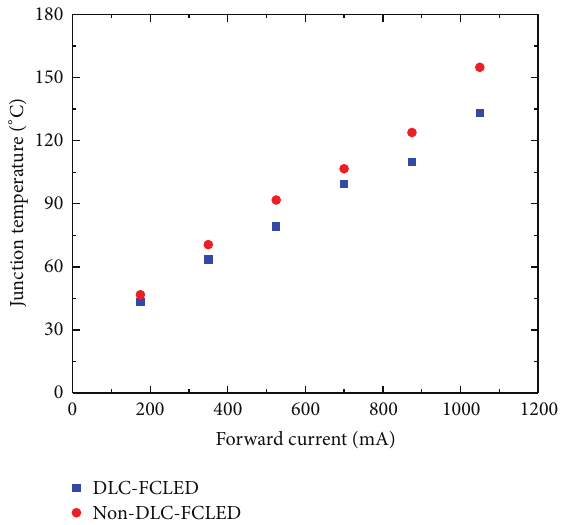
Figure 5: The forward voltage as a function of the heat sink temperature at an injection current of 1,000